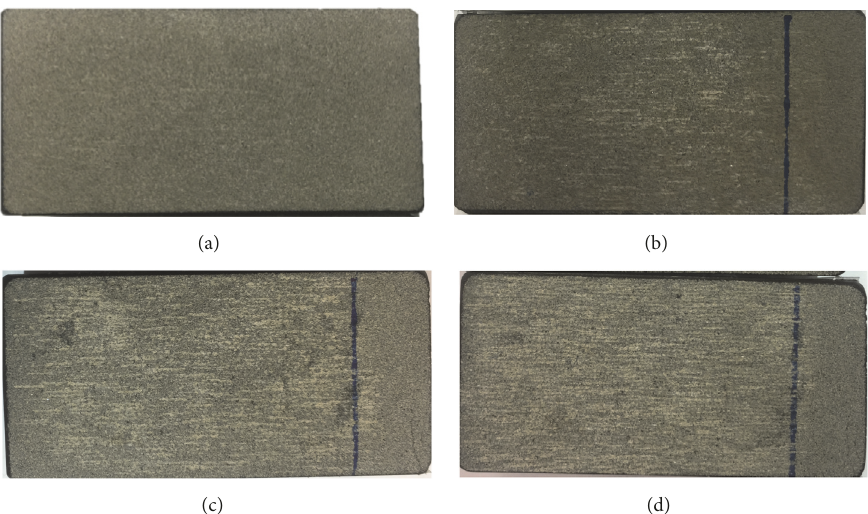
Figure 7: (a) Fracture surface before shearing, (b) fracture surface after shearing at a normal stress of 1MPa, (c) fracture surface after shearing at a normal stress of 3 MPa, and (d) fracture surface after shearing at a normal stress of 5 MPa. The number of striations increases as the normal stress increases.